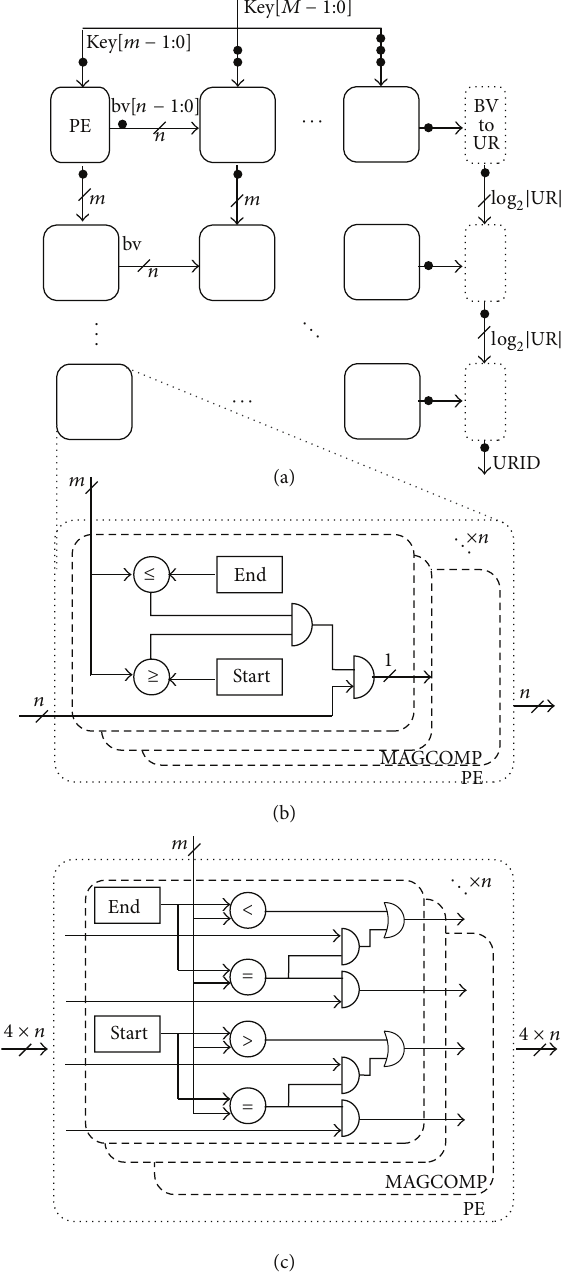
Figure 14: Explicit range match: (a) 2D pipeline of PEs, (b) previous node architecture (PX support), and (c) proposed node architecture (AR support).